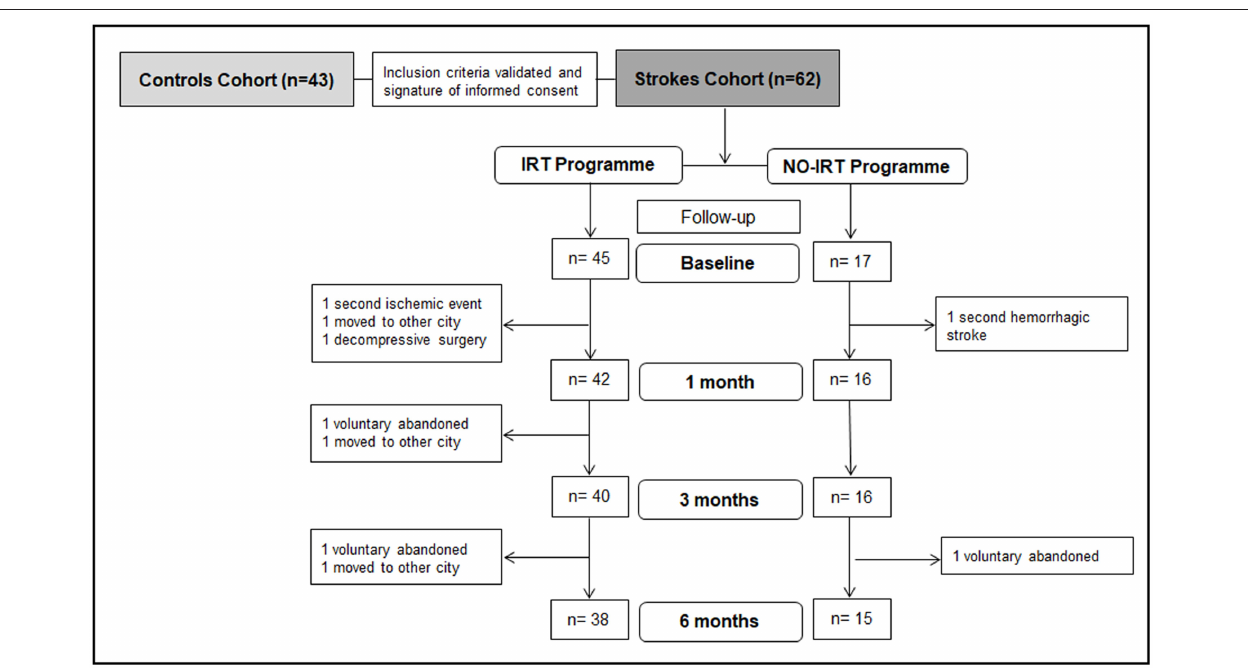
FIGURE 1 | Study design. Scheme showing the studied cohorts and follow-up visits when a battery of tests to assess motor and functional status was conducted together with blood samples extraction. Controls were recruited in a unique inclusion visit when blood samples were